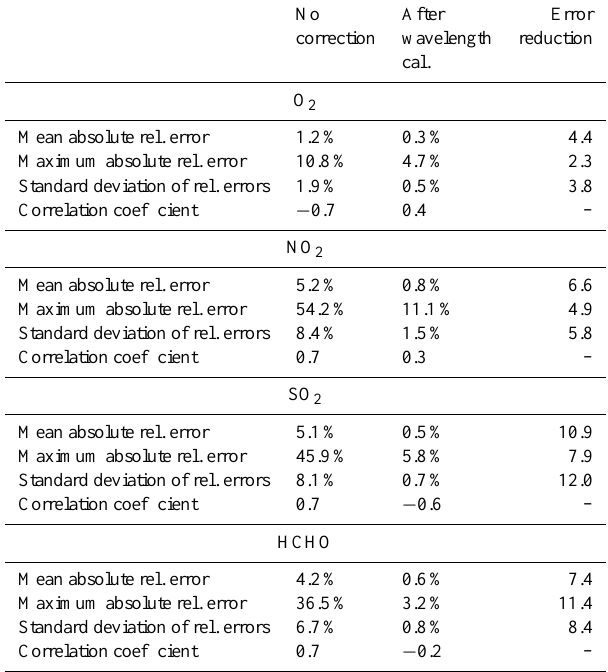
Table 3. Summary of results including wavelength calibration, tak- ing into account only ground pixels with maximum cloud fraction of 20%. No After Error